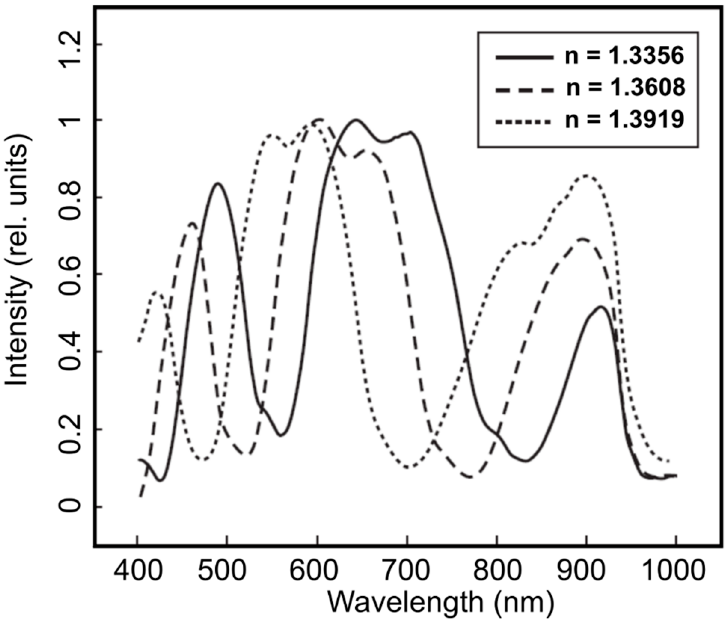
Figure 4. Transmission spectra of MOF samples filled with glucose solutions with different refractive indices. The change of glucose concentration from 1% to 40% induces the refractive index (n) variation in the interval 1.3356–1.3919 (at 20 °C). Reproduced with permission from [34].